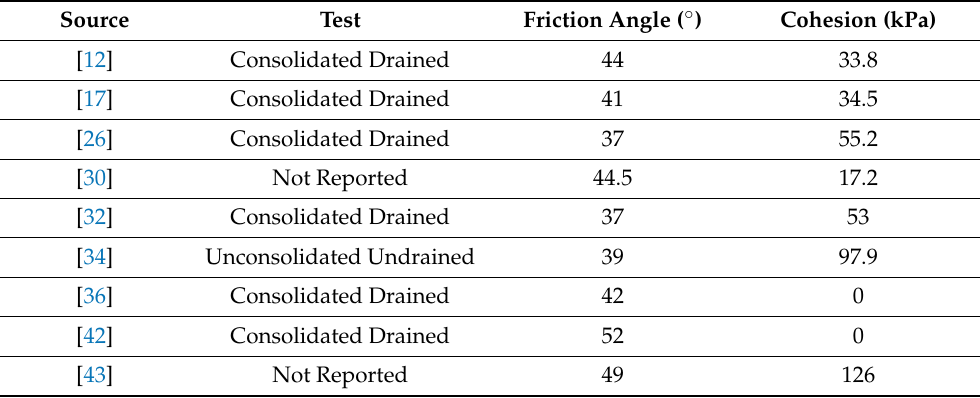
Table 4. Shear strength and cohesion values for RAP from literature. Source